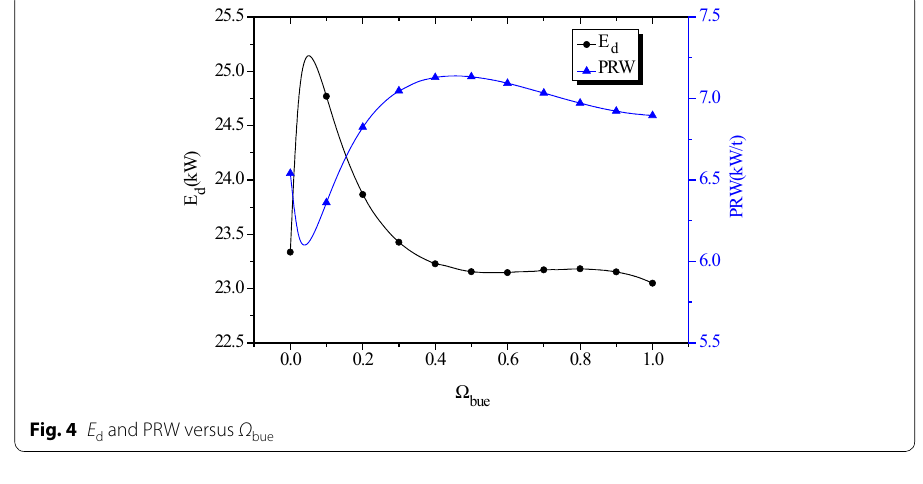
Fig. 4 E d and PRW versus Ω bue